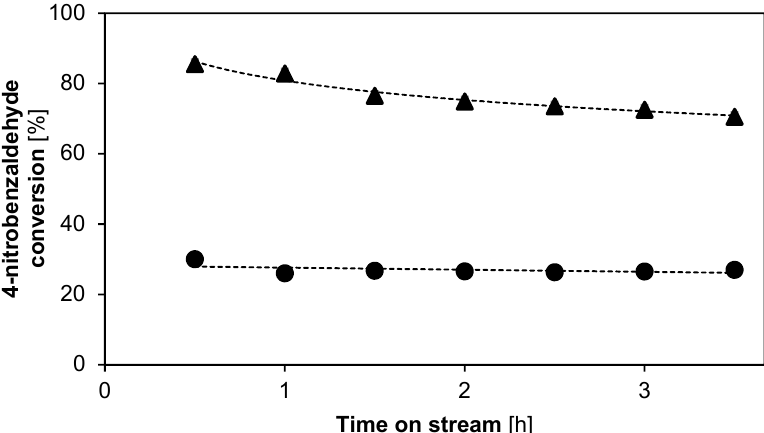
Figure 6. Conversion as function of time on stream for the aldol reaction between acetone and 4-nitrobenzaldehyde using hexane as a solvent. ● : cooperative acid-base catalyst, ▲ : monofunctional base catalyst. (T = 55 °C, P tot = 180 kPa, site time = 165.1 mol site s mol − 1 , 0.6 wt % 4-nitrobenzaldehyde, 55.6 wt % acetone, 43.5 wt % hexane, 0.25 wt % methyl-4-nitrobenzoate (internal standard). Fixed error of 1.8%, not visible on the scale). Line is a guide for the eye.